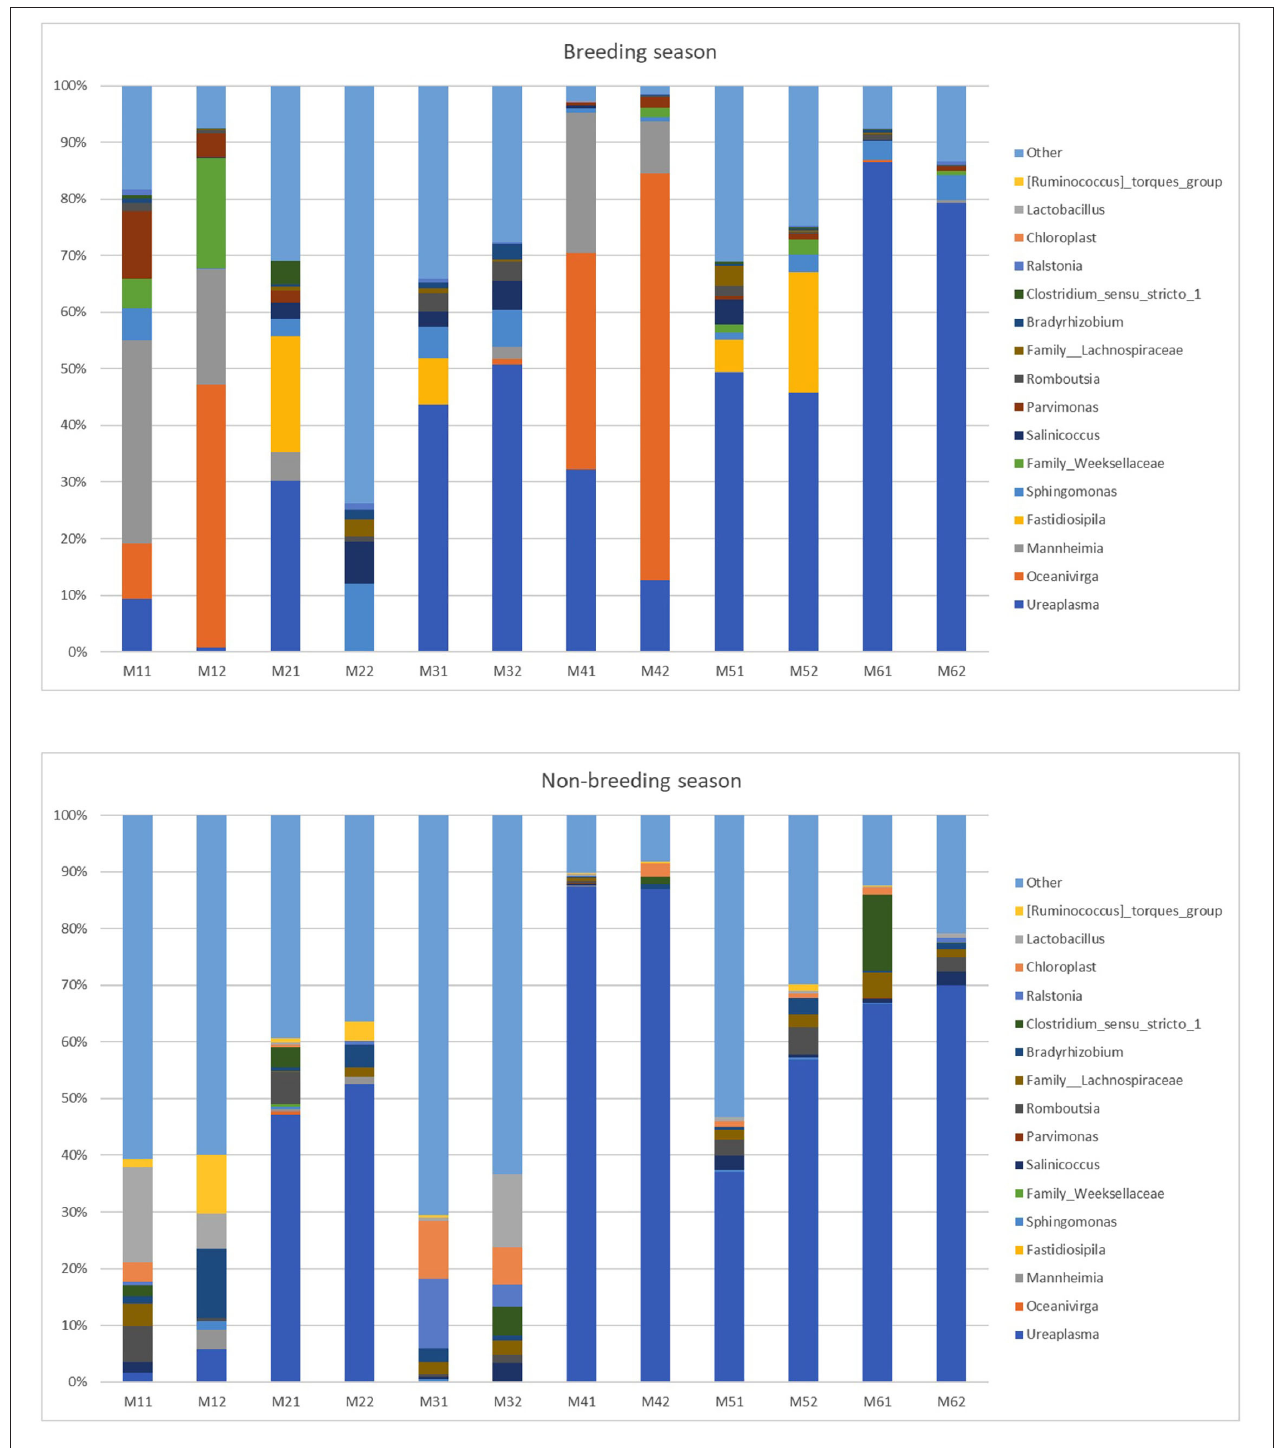
FIGURE 4 | Relative abundance of taxa at the genus level in the individual goat buck ejaculates collected during the breeding and non-breeding seasons (only the taxa with a mean relative abundance > 1.5% for the breeding or non-breeding seasons are represented). The letters on the x-axis correspond to each individual sample. M11 and M12 are the samples of Male 1; M21 and M22 are the samples of Male 2; M31 and M32 are the samples of Male 3; M41 and M42 are the samples of Male 4; M51 and M52 are the samples of Male 5; and M61 and M62 are the samples of Male